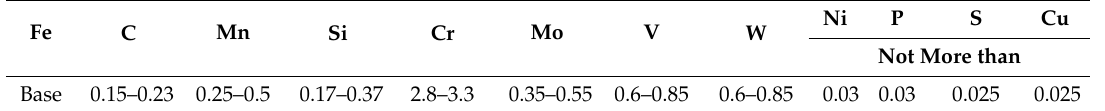
Table 1. Chemical composition of the 20Cr3MoWV steel, wt %.